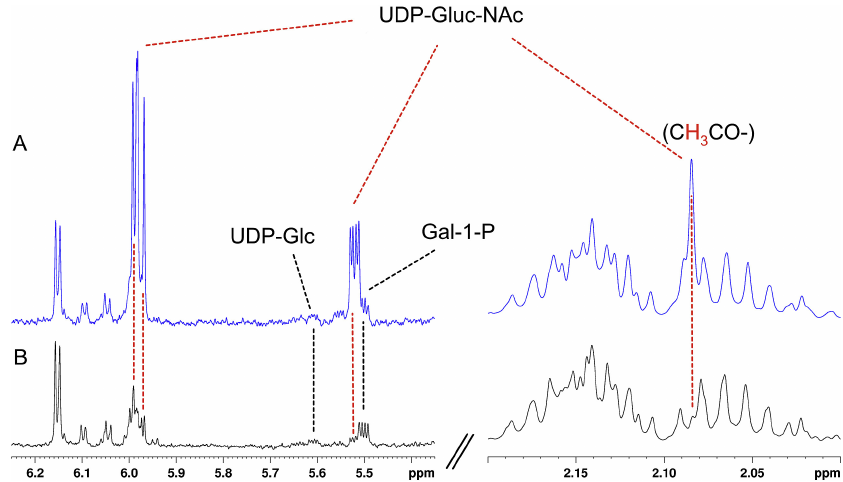
Figure A4. ( A ): The spiking of UDP-nacetylglucosamine (UDP-Gluc-NAc) allows its identification and quantitation. ( B ): The same spectrum of A without the addition of UDP-Gluc-NAc. Figure reprinted from Ref. [145] under the terms of the Creative Common CC-BY